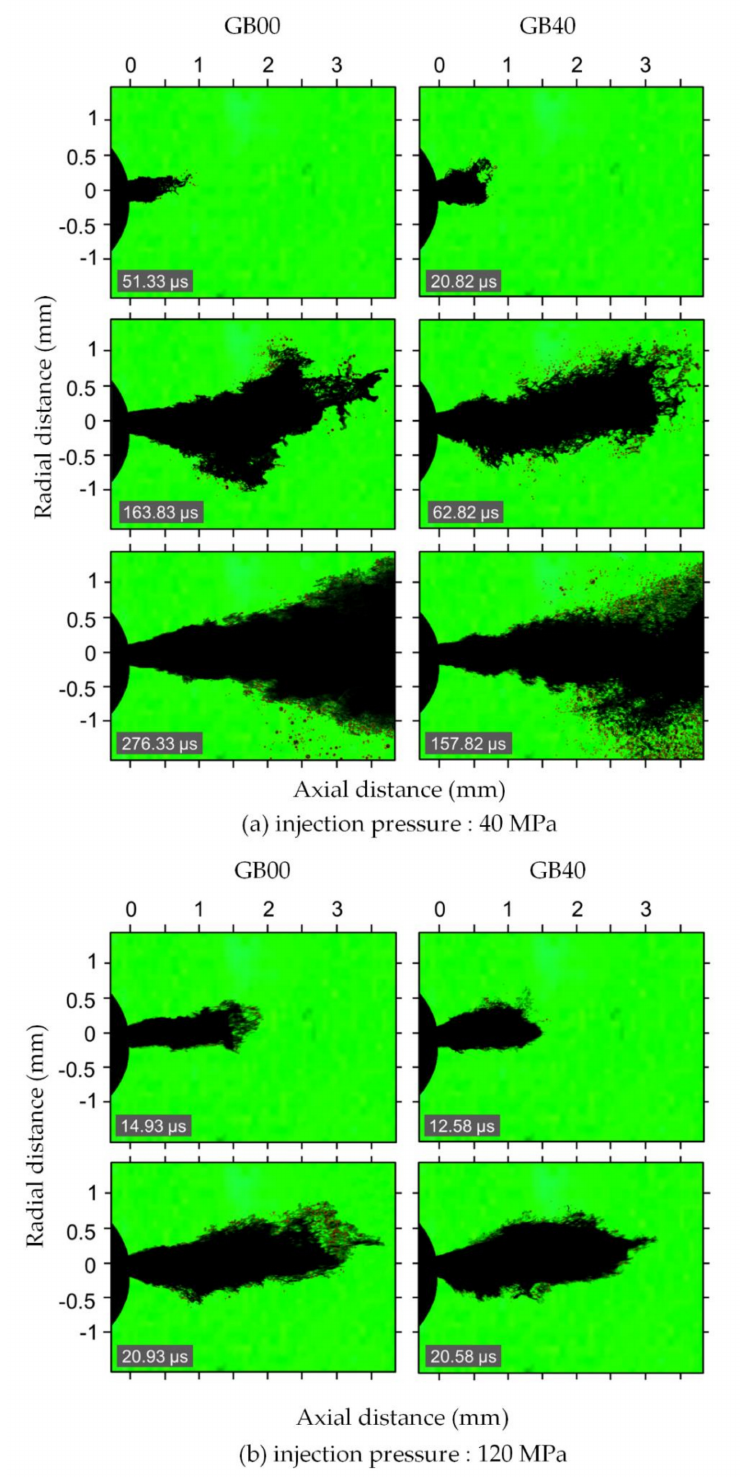
Figure 5. Microscopic images obtained under injection pressures of ( a ) 40 MPa and ( b ) 120